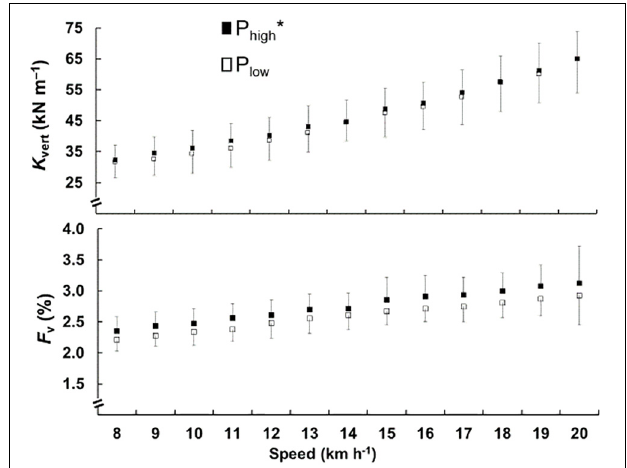
FIGURE 3 | Mean and standard deviation of the vertical stiffness ( k vert ) in the top chart and relative vertical force ( F v ) in the lower chart, for vertical distance traveled, is plotted as a function of the speed. The black square represents the P high and the open square represents the P low . The ∗ represents significant difference between the groups.